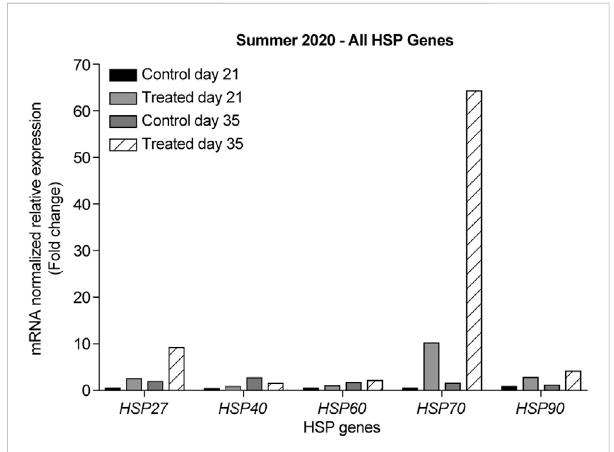
FIGURE 5 ΔΔ Ct of the relative normalized expression of HSP27 , HSP40 , HSP60 , HSP70 , and HSP90 against GAPDH in the control (indoor) vs. heat-treated (outdoor) chicks in the summer of 2020, using retinas from 21- and 35-days old chicks. ( n = 3 in each group). HSP, heat shock protein.